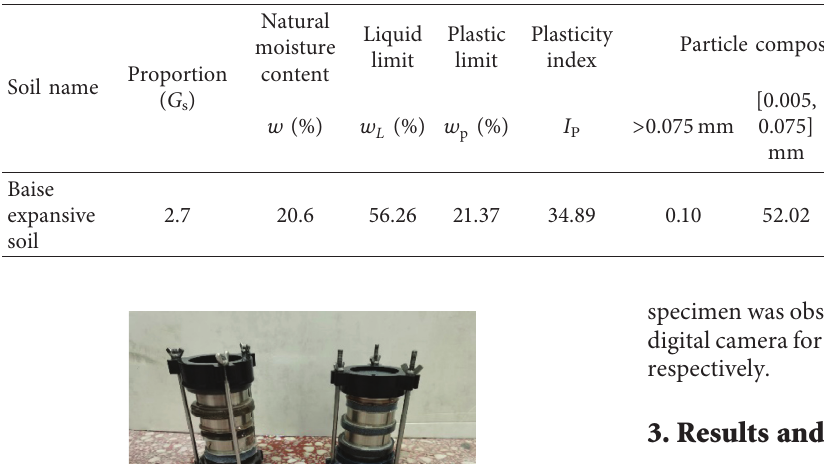
Table 1: Characteristic index of expansive soil.